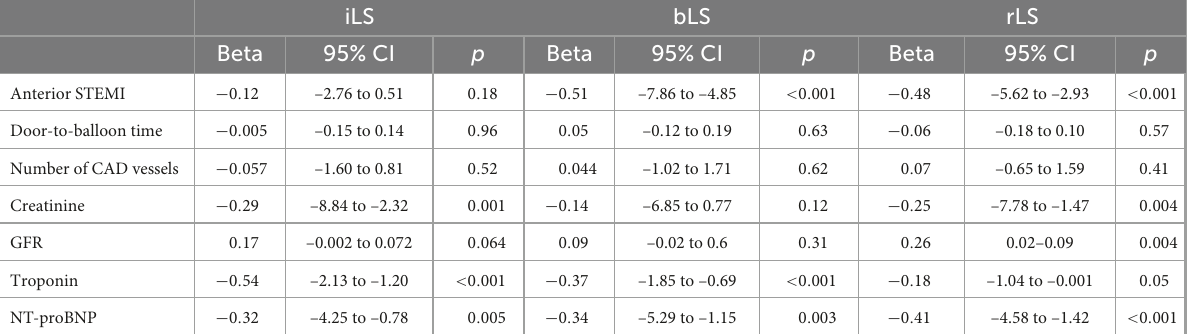
TABLE 2 Results of univariate linear regression analysis for regional